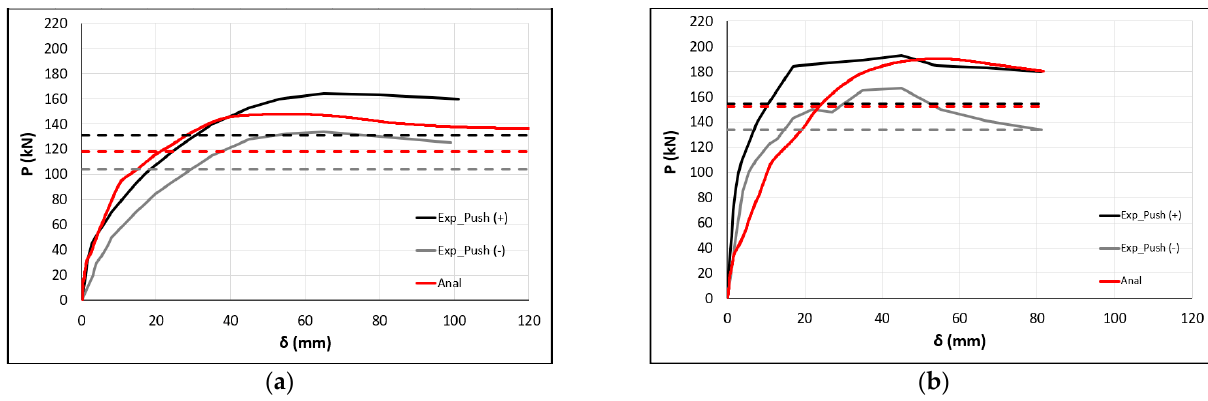
Figure 10. Analytical base shear force–displacement curve for ( a ) A1F and ( b ) B2, compared against the experimental ones.